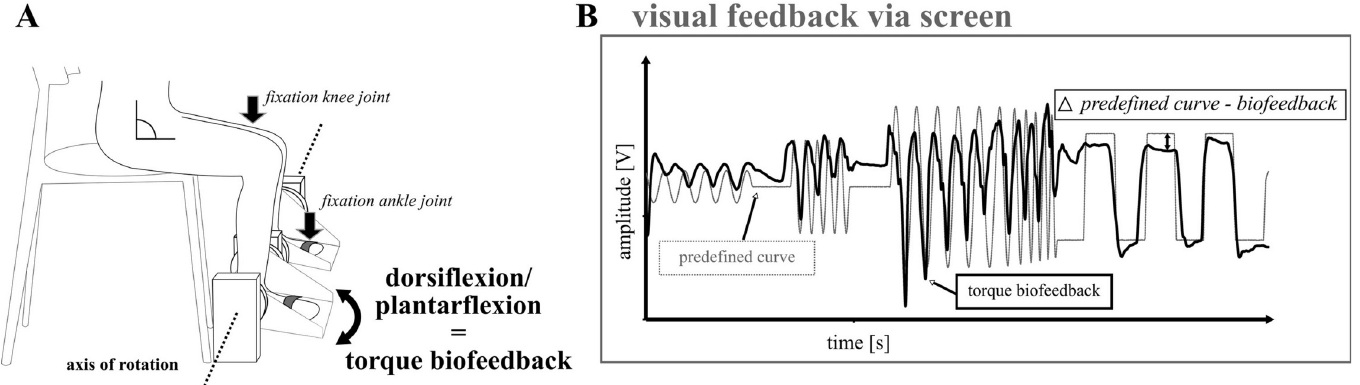
Fig 3. Assessment setup for motor accuracy. Participants sat upright in a chair and were asked to flex and extend their ankle joint (A). Fixations were provided at the knee and ankle; the ankle joint was in line with the rotation axis of the ergometer. Ankle joint position was visualized for plantarflexion and dorsal extension (B) as biofeedback. Participants were asked to replicate the predefined (grey) curve with as accurately as possible (black). Errors were calculated by means of differences between the predefined curve and the position signal in Δ